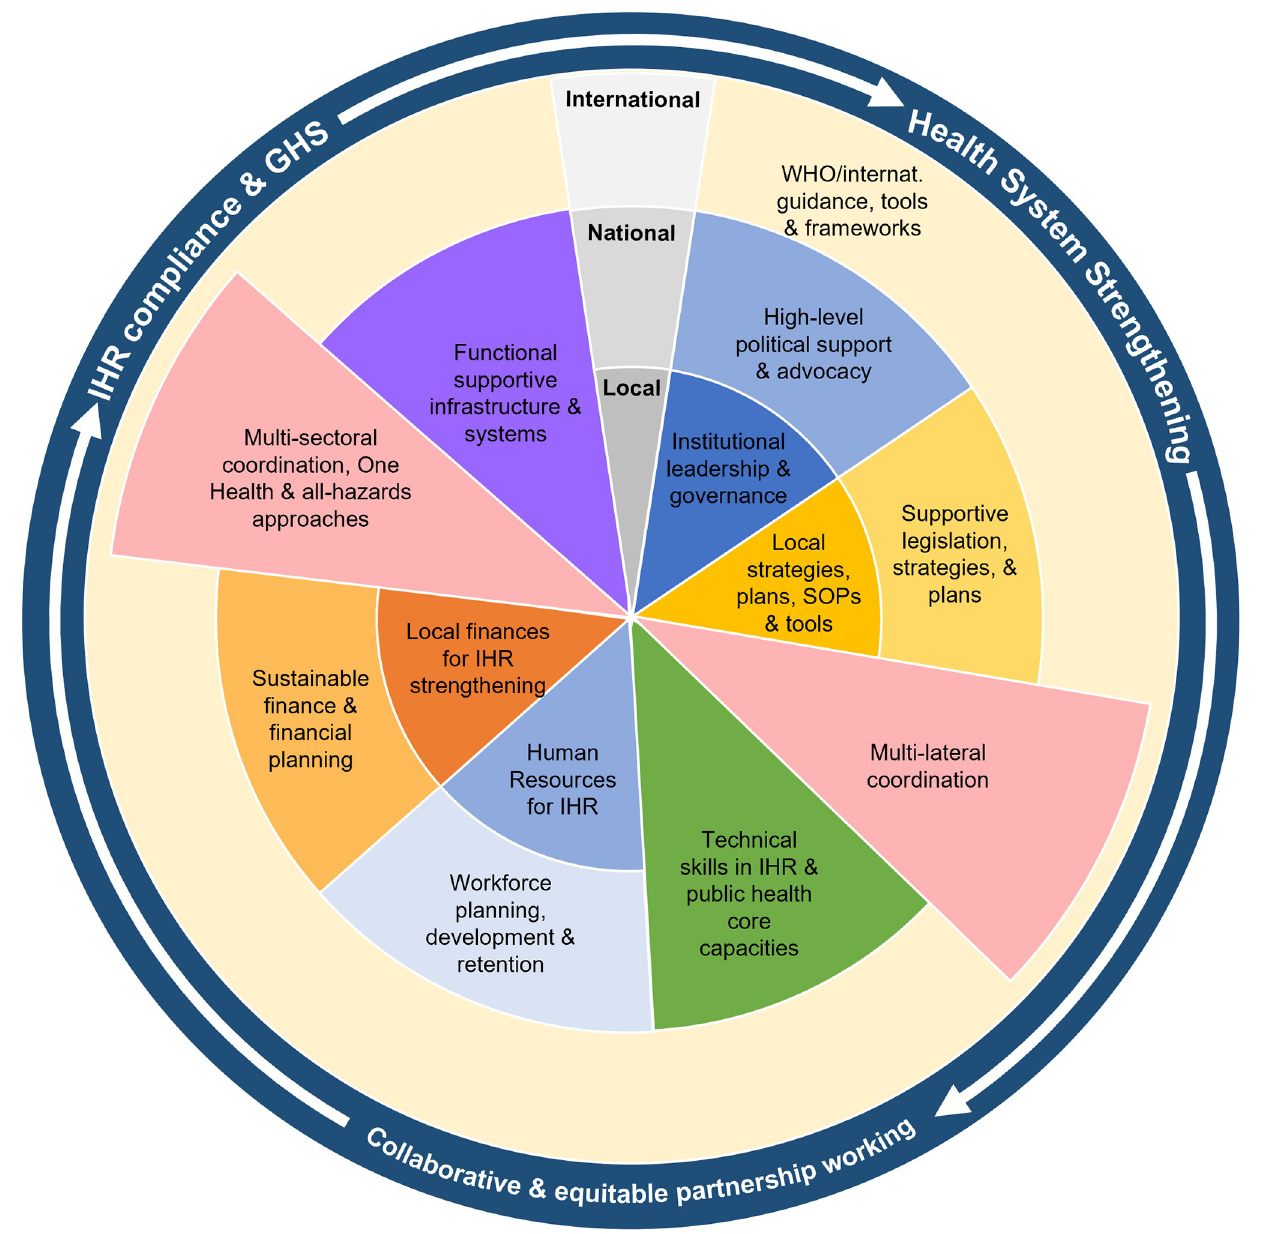
Fig 1. Conceptualisation of important factors and approaches to global health security capacity building. Schematic representation of emerging themes: key elements for sustainable GHS and IHR capacity building and health system strengthening operating at local, national and international levels.